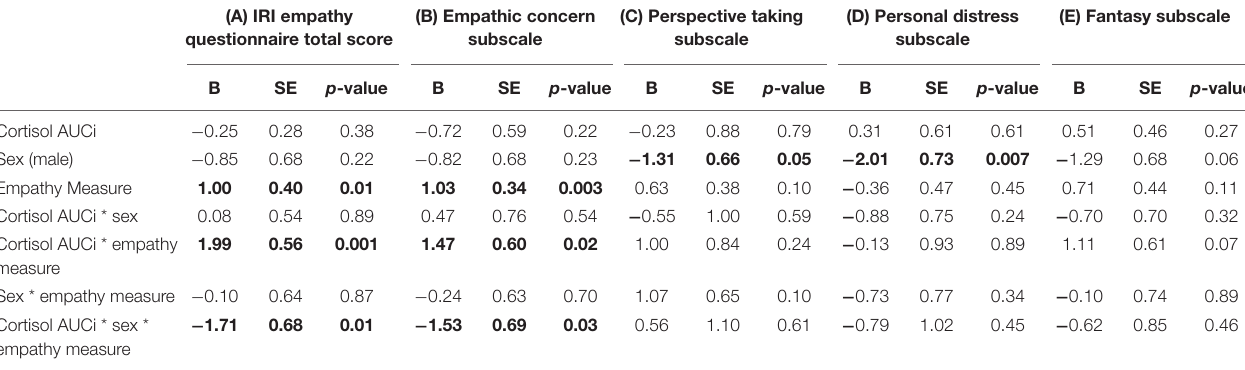
Every three columns represent a different scale for IRI empathy questionnaire—(A) Total score, (B) Empathic concern, (C) Perspective taking, (D) Personal distress, and (E) Fantasy. Presented are coefficient estimates (betas), standard errors, and p-values of each factor. Sex is a dummy variable with female as baseline. Significant